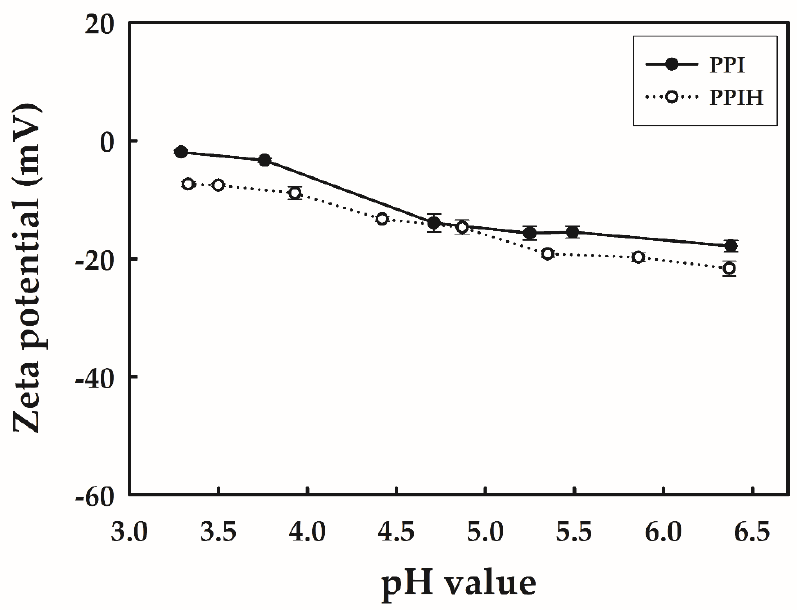
Figure 2. Effect of pH on the zeta potential of PPI and PPIH. Each value is represented as the mean ±SD.